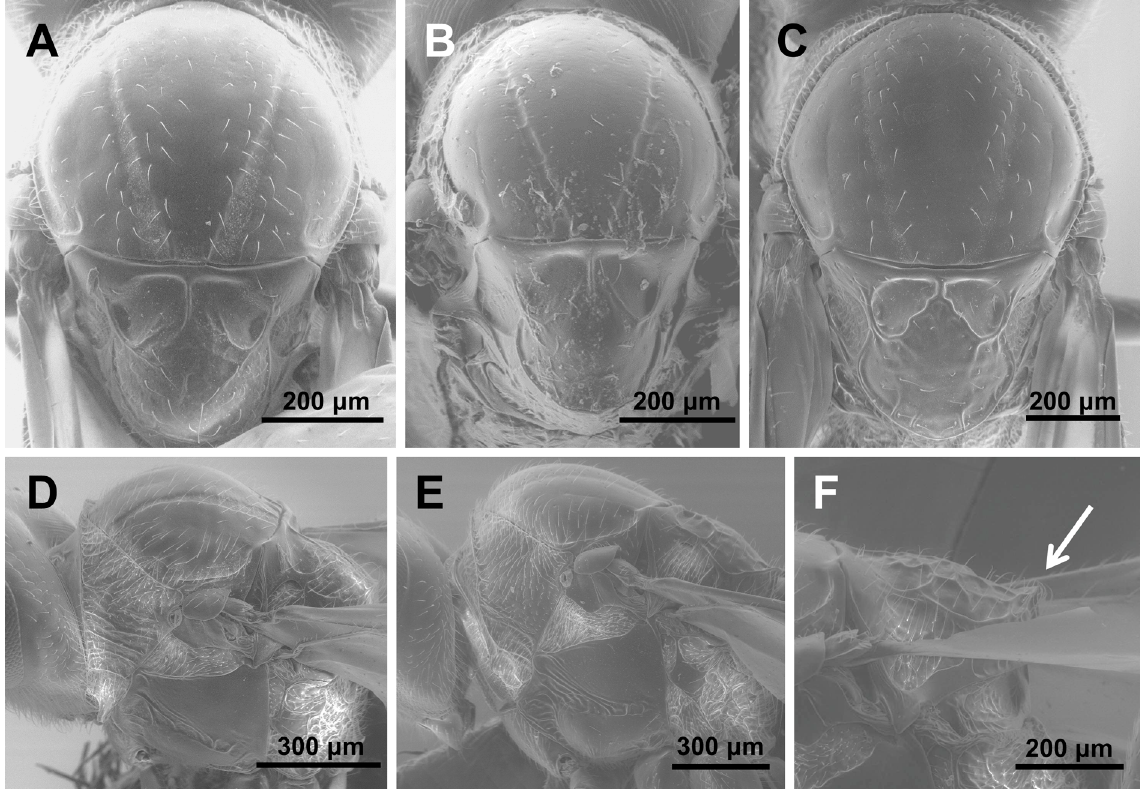
Fig. 2. A–C . Mesosoma in dorsal view. A–B . Anacharis eucharoides (Dalman, 1818). C . A.